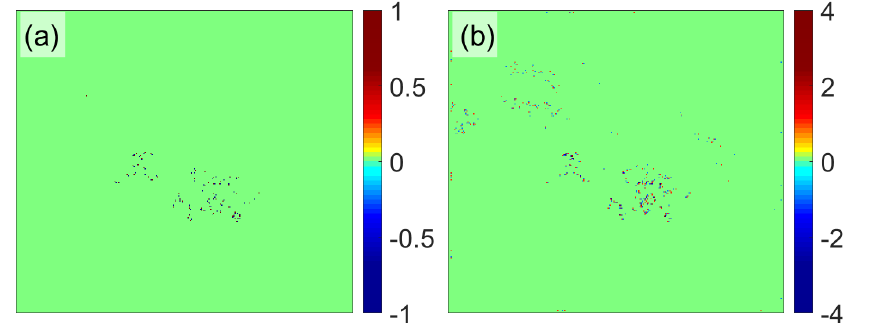
Figure 3. ( a ) The residue distribution of Figure 2a obtained by LPM-TSPA. ( b ) The residue distribution of Figure 2b obtained by